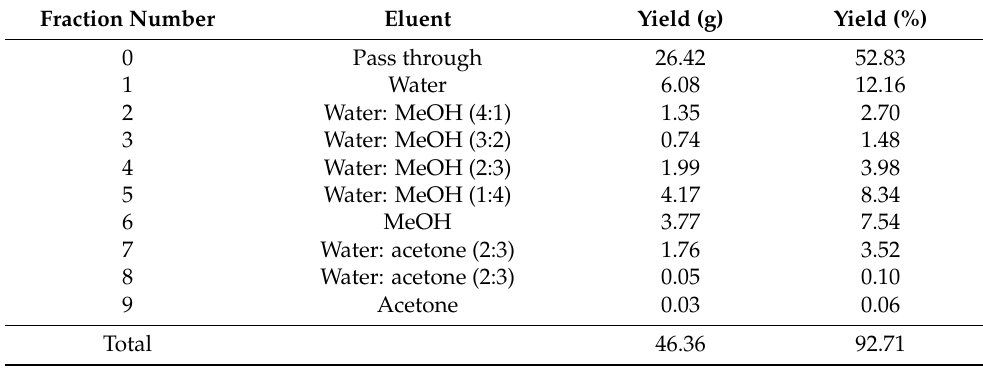
Table 3. Fraction profiles of